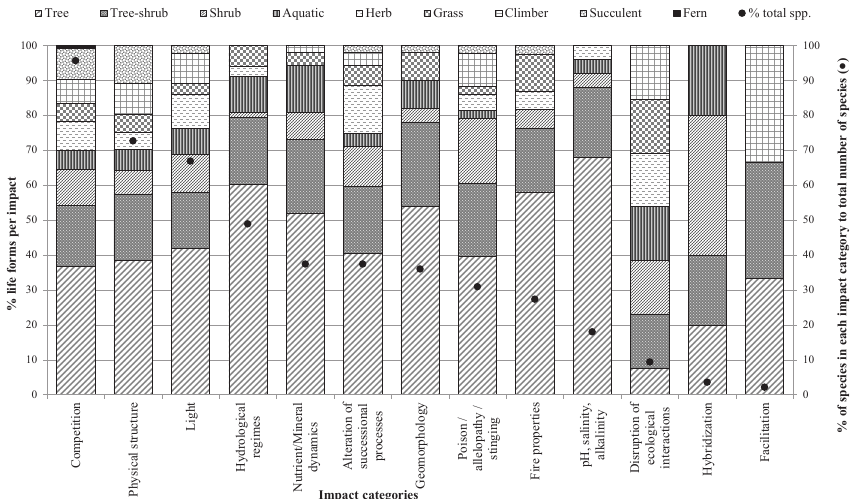
Figure 2. Percentage life forms and total percent species per impact category. Columns show the percent of life forms per each impact category, with the total number of species per impact category above each column. For example 37% of the species in the competition category are trees and 39% of the species that can impact through changes to physical structure are trees. The black dots show the percent of species in each impact category of the total species list. For example, 96% of the species could impact through direct competition, while 73% could impact through changing the physical